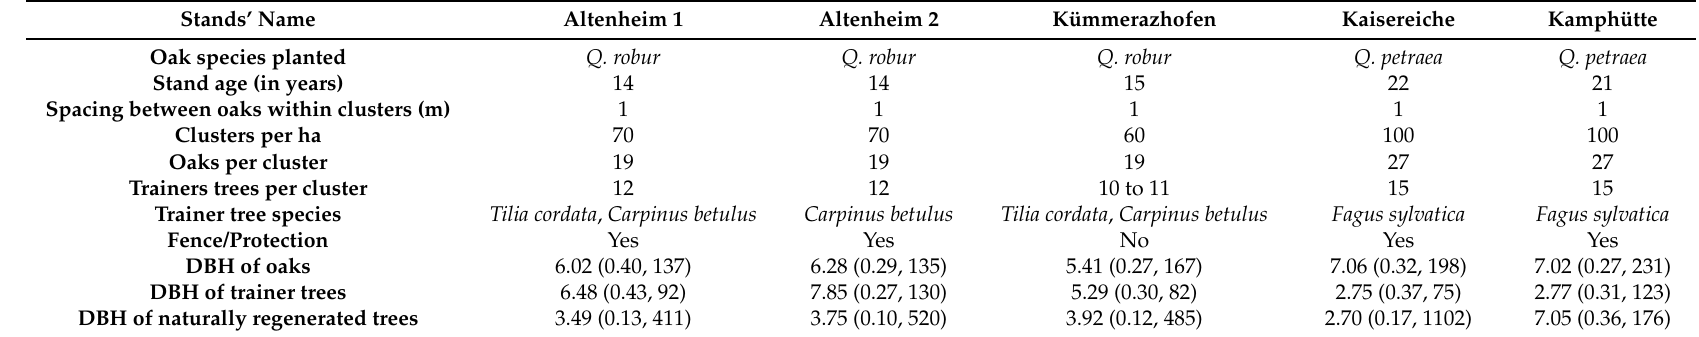
Table 2. Details of group planting designs and current mean diameter at 1.3 m height or DBH (in cm) of planted oaks, trainer and naturally regenerated trees in group planting stands. Standard error and number of trees inventoried are given within brackets.